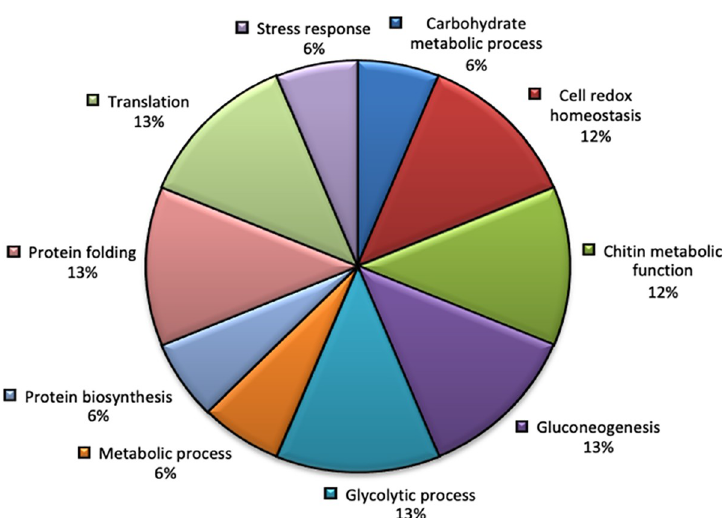
Fig 1. Main biological processes of the identified proteins in the non-embryonated egg extract proteome (EE) of T . trichiura according to information obtained from the Gene Ontology (GO) database https://www.uniprot.org.